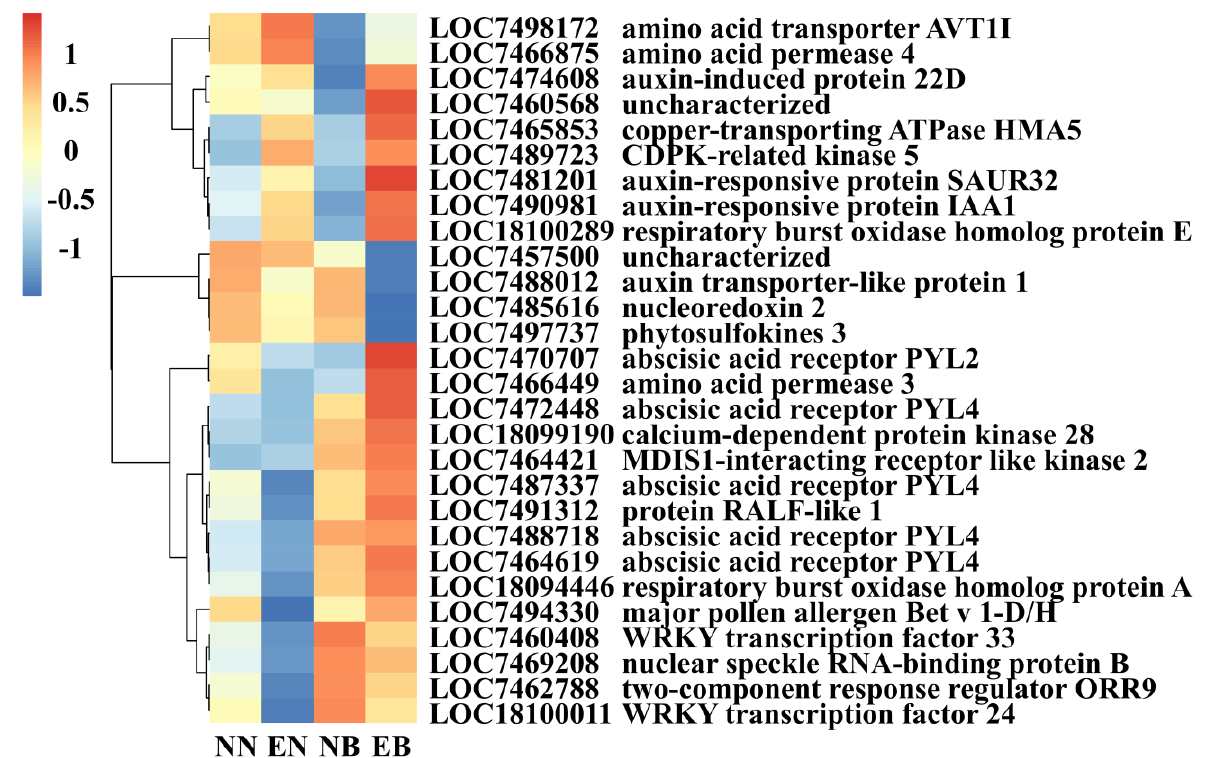
Figure 4. Heat map of DEGs related to signal transduction